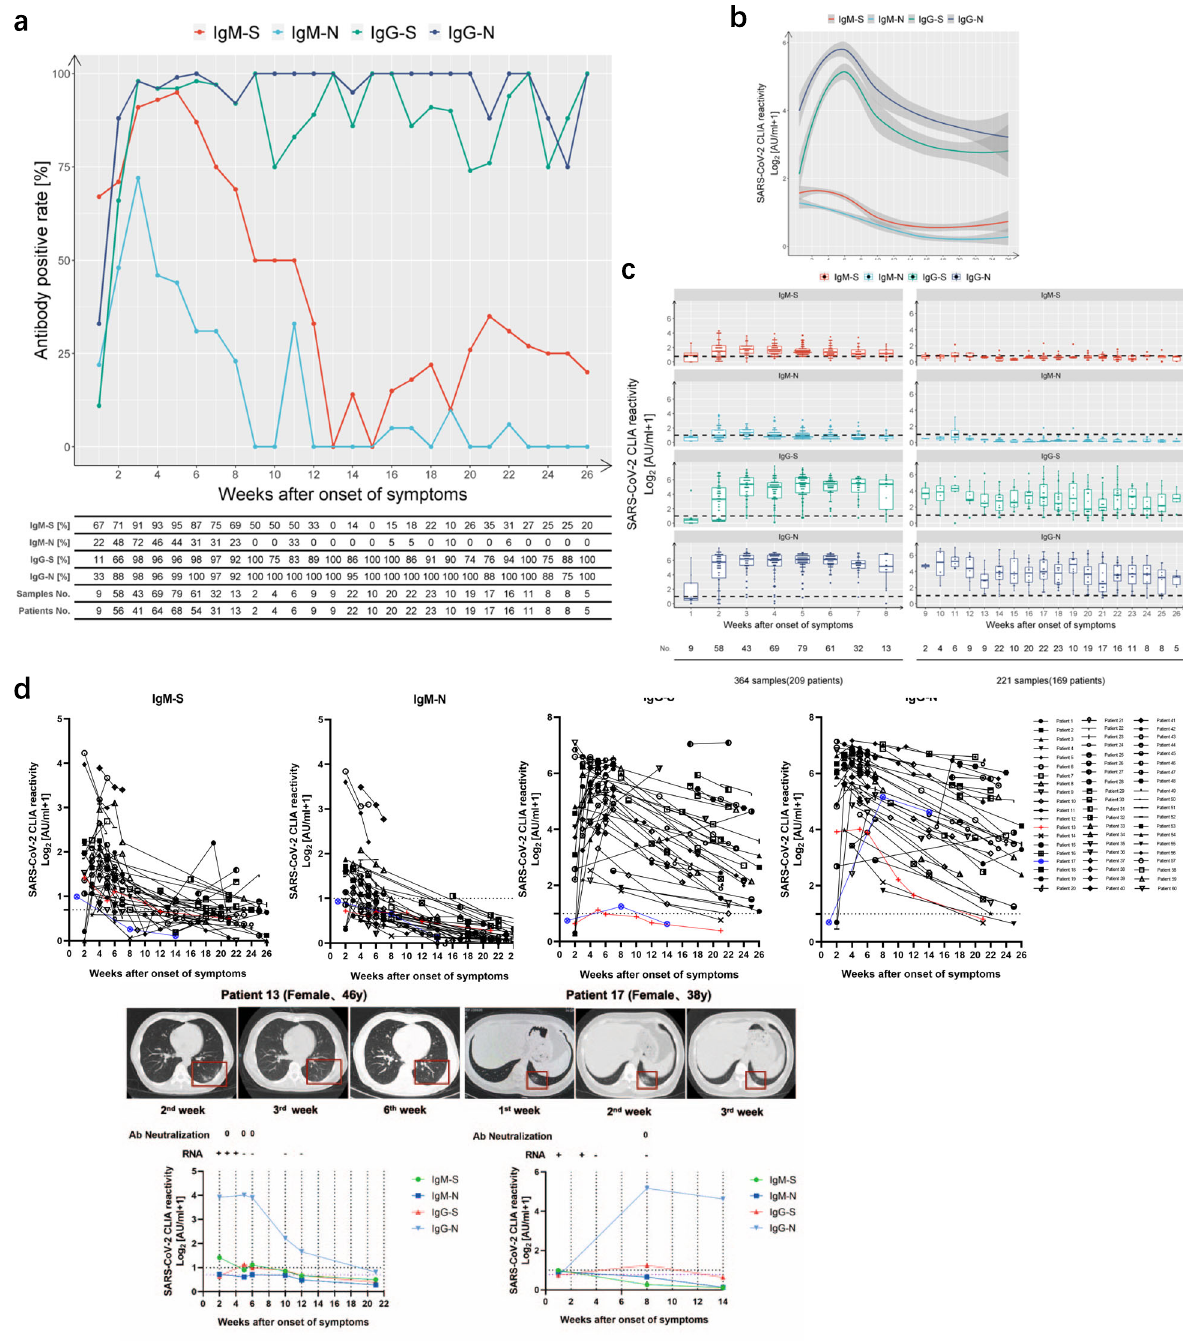
Fig. 1 Longitudinal analyses of IgM and IgG against SARS-CoV-2 S/N in COVID-19 patients. IgM and IgG against the RBD of the spike protein ( “ S ” ) and the nucleoprotein ( “ N ” ) of SARS-CoV-2 of 585 samples obtained from 349 patients were detected by capture chemiluminescence immunoassays (CLIA). a Positive rate of individual antibodies tested at the indicated dates following onset of symptoms. b , c The plasma antibody levels of IgM-S (red), IgM-N (light blue), IgG-S (green), and IgG-N (dark blue) in patients with different disease courses are presented. The line shows the mean value expected from a Lowess regression model, with shaded area representing 95% con fi dence interval in b . The boxes in c show medians (middle line), 75% quartiles (upper bound) and 25% quartiles (lower bound), and the whiskers show 1.5× the IQR above and below the box. The table below the fi gure represents the number of samples at each time point. d Sequential sampling and analyses of antibody titers in 60 COVID-19 cases. Characteristics of two patients with low IgG antibody levels. Patient 13: a 46-year-old female with fever, cough, dizziness, and fatigue for 6 days; patient 17: a 38-year-old female with fever and chest tightness for 4 days. The cutoff value for IgM-S detection was 0.7 AU/ml. The cutoff value for IgM-N, IgG-S, and IgG-N was 1 (shown on the left Y axis). value after around 9 weeks. The titers of IgG-N and IgG-S maintained at high levels until the end of the observation period reached their peaks at weeks 4 and 5, respectively. After a 26 weeks post symptom onset. Thus, SARS-CoV-2-speci fi c IgG contraction phase, in which titers constantly decreased during responses were very similar to antibody responses against many weeks 6 – 14, IgG-N and IgG-S titers stabilized and were other viruses with a peak activity a few weeks after infection,